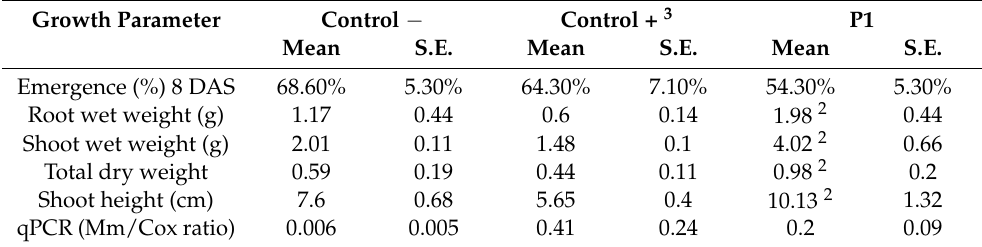
Table 4. Trichoderma asperellum late wilt control in sprouts at 42 DAS 1 . Growth